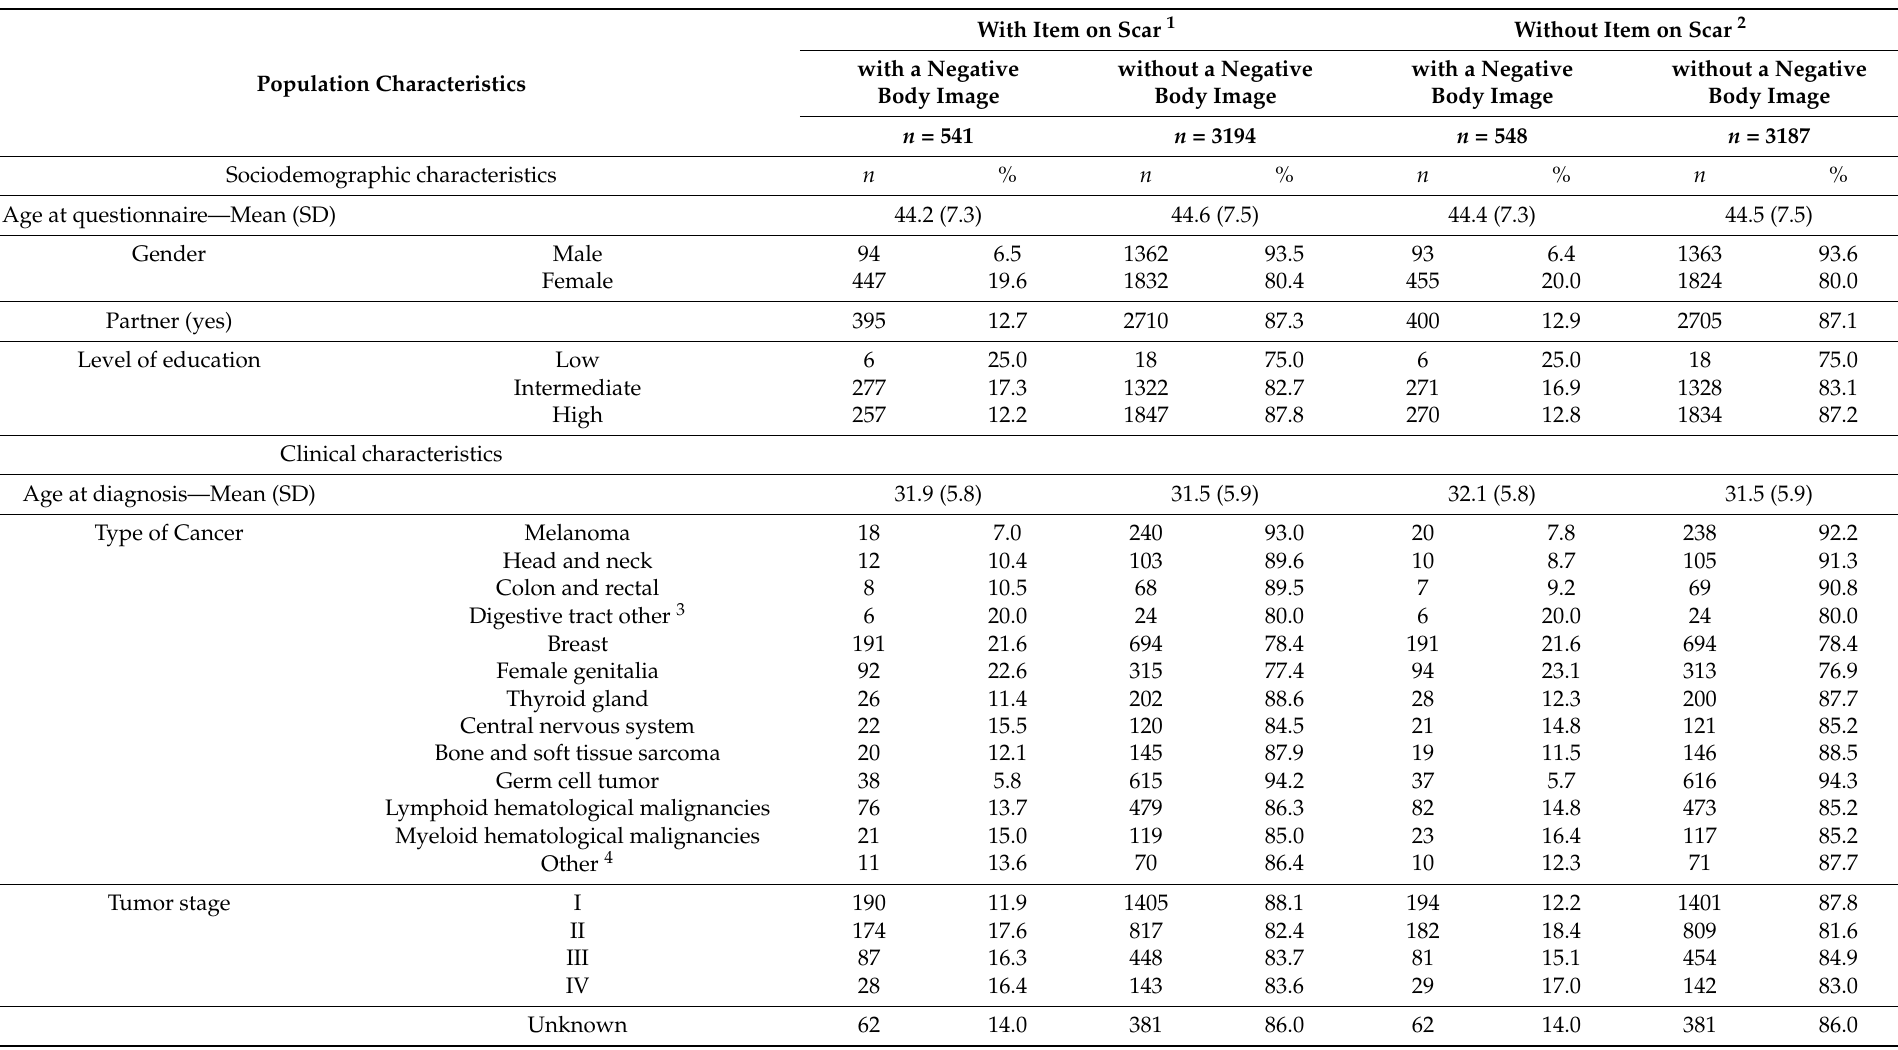
Table A1. Characteristics of AYA survivors with and without the item on dissatisfaction with